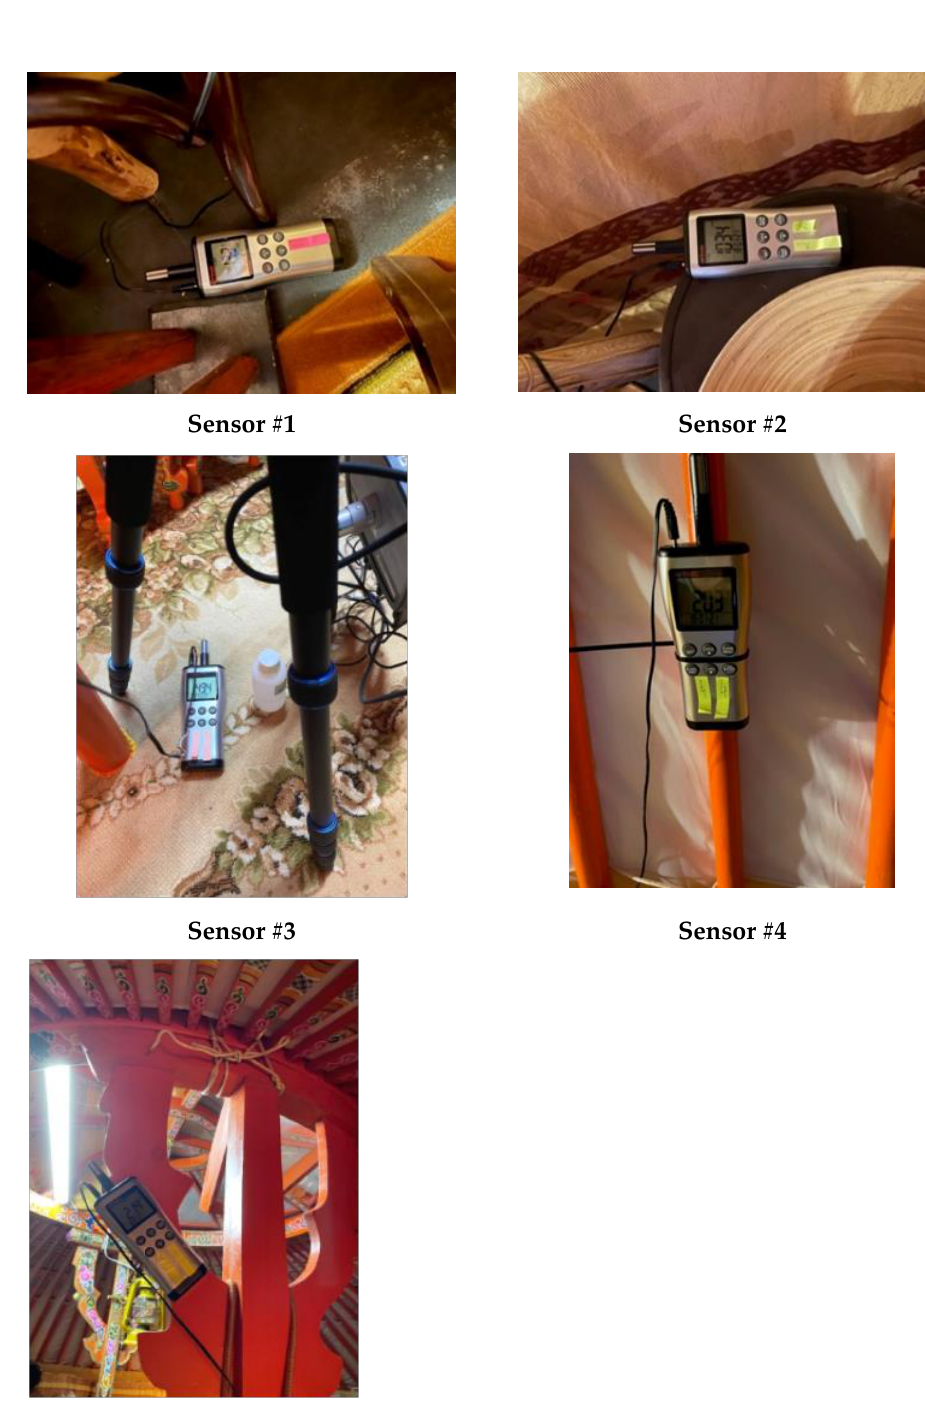
9 of 19 Figure 5. CO 2 sensor location map. Table 2. Description of sensors’ locations. Sensor Number